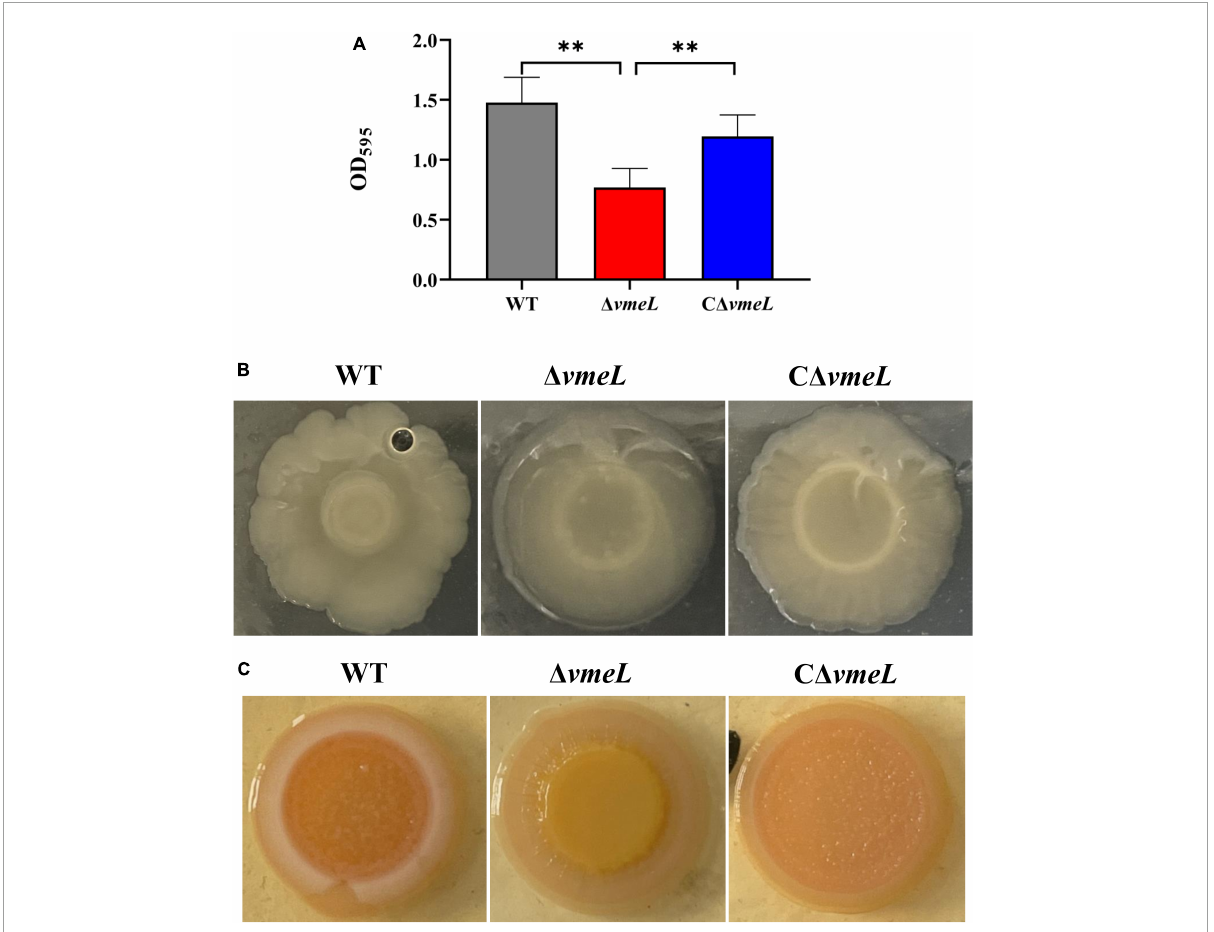
FIGURE1 VmeL is required for biofilm formation by Vibrio parahaemolyticus . (A) Optical density at 595 nm (OD 595 ) for crystal violet biofilm assays. Data shown are the mean of six replicates. (B) Colony morphology of strains cultivated on heart infusion plates for at least 48 hours. (C) Strains cultivated on Congo Red plates for eight days and photographed. WT, wild-type; (cid:49) vmeL , vmeL deletion mutant; C (cid:49) vmeL , deletion mutant complemented strain. ** indicates statistical significance at P <